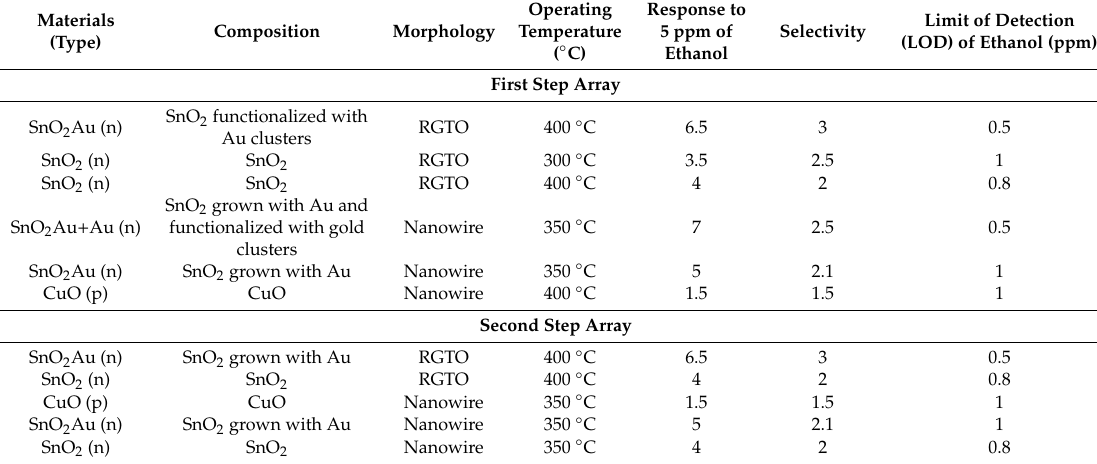
Table 1. Type, composition, morphology, operating temperature, response ( ∆ R / R), selectivity (response ethanol / response carbon monoxide), and limit of detection (LOD) of ethanol for both S3 sensors arrays made at the SENSOR